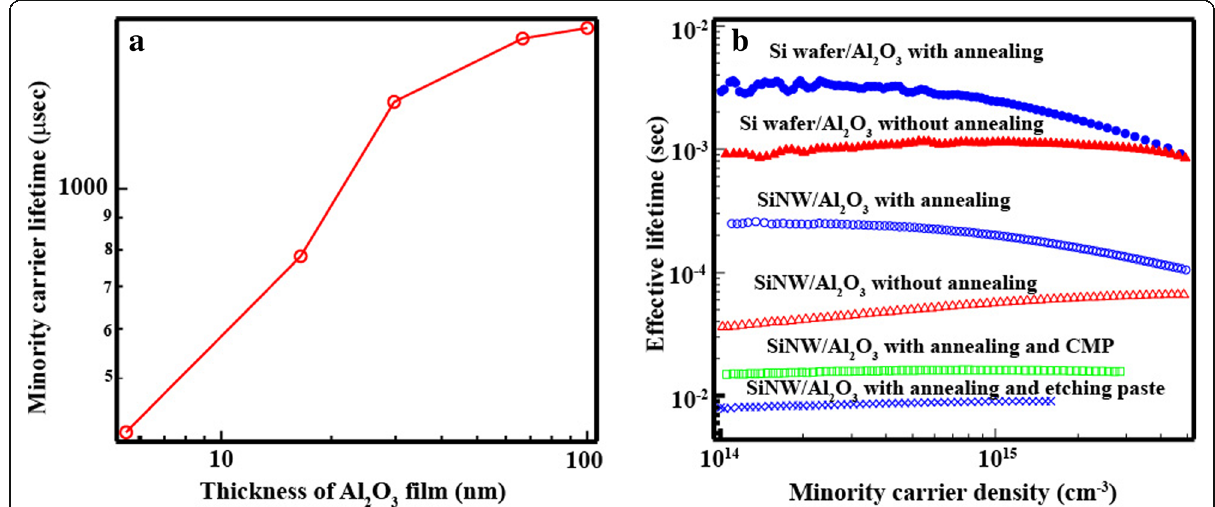
Fig. 3 a The minority carrier lifetime of Si wafer/Al 2 O 3 as the function of the Al 2 O 3 film thickness. b The minority carrier lifetime of each sample as the function of the minority carrier